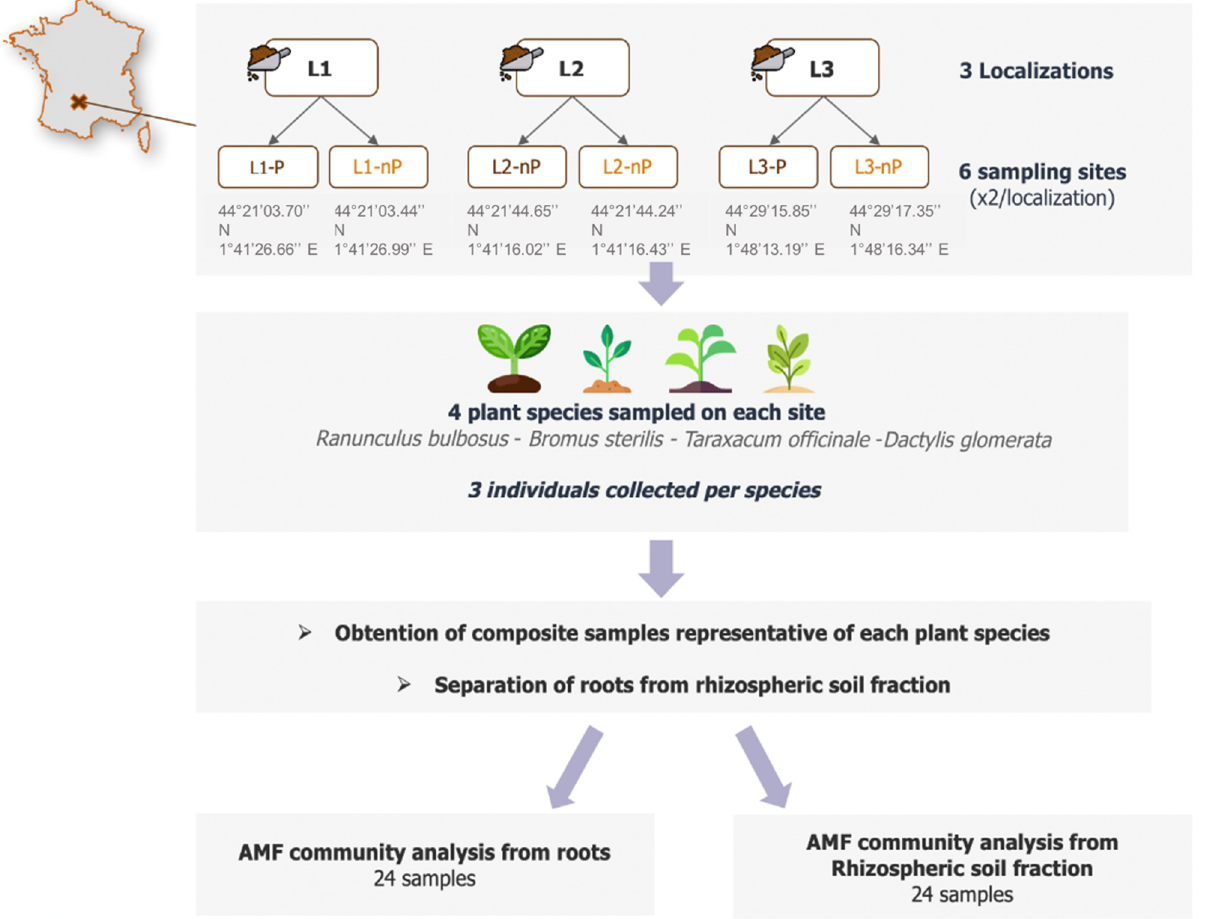
Figure 1. Sampling sites and experimental design.